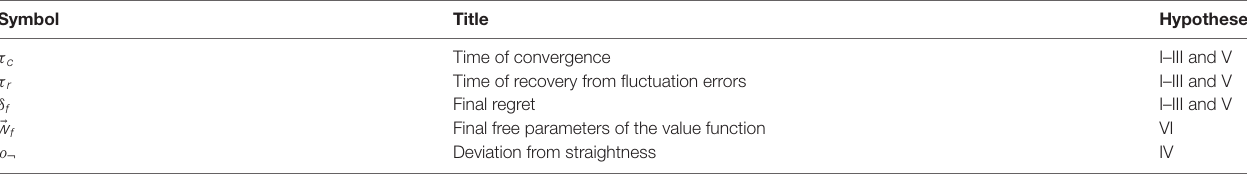
TABLE 3 | Statistics used to test the